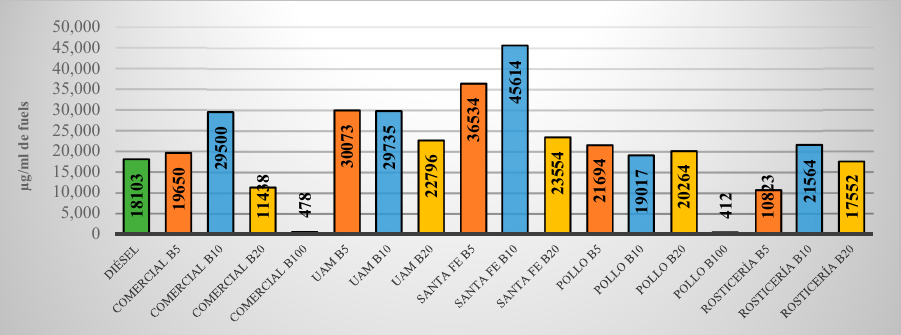
Figure 1. Concentrations of total PAHs in the blends studied, in µg mL − 1 of fuel.